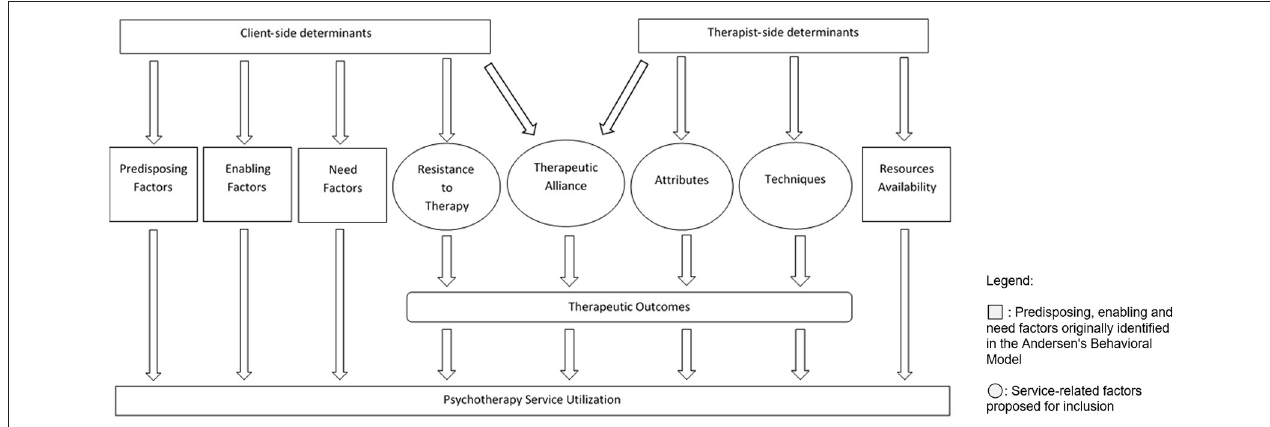
FIGURE 2 | Proposed expanded framework for psychotherapy help-seeking behavior adapted from Andersen’s Health Utilization Model.